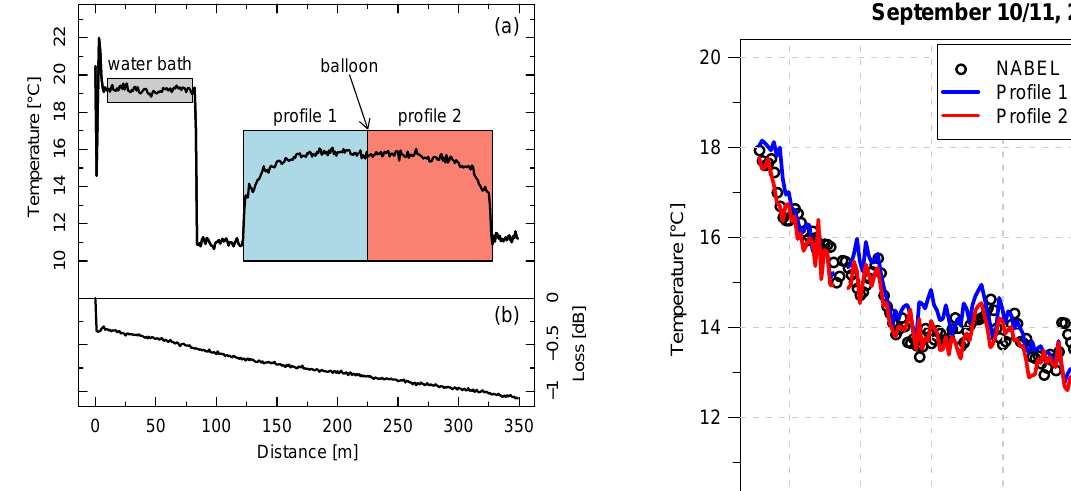
Fig. 2. DTS record of 11 September, 02:20 a.m. along the first 350m of the fiber cable. (a) Temperature measurements in ◦ C, the shaded areas show the location of the calibration section (wa- ter bath) and the upward and downward atmospheric profile fiber cable sections. (b) Loss of signal intensity (dB).